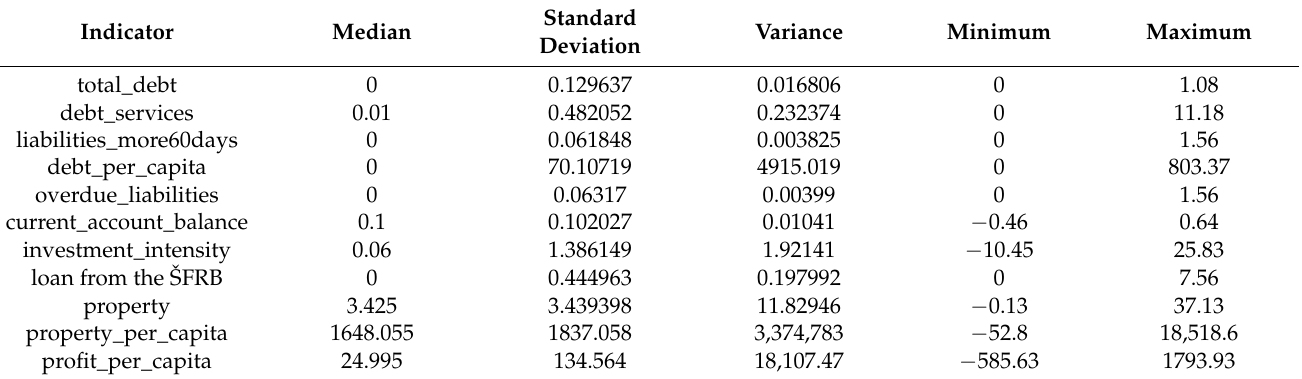
Table 1. Descriptive statistics for selected indicators.